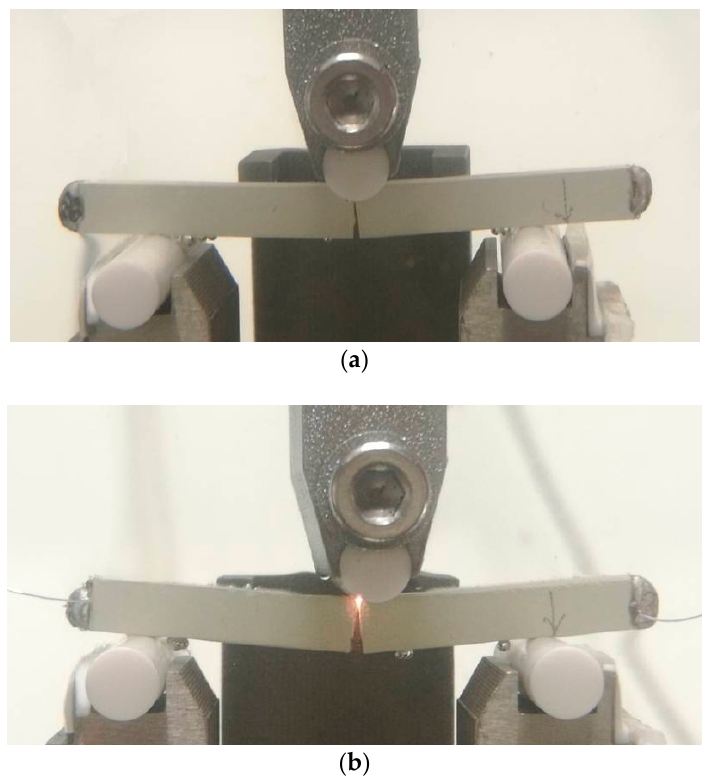
Figure 11. Specimens in fracture testing ( a ) without an applied electric current and ( b ) under the combined electrical and mechanical loading (1.63 × 10 4 A m − 2 ).